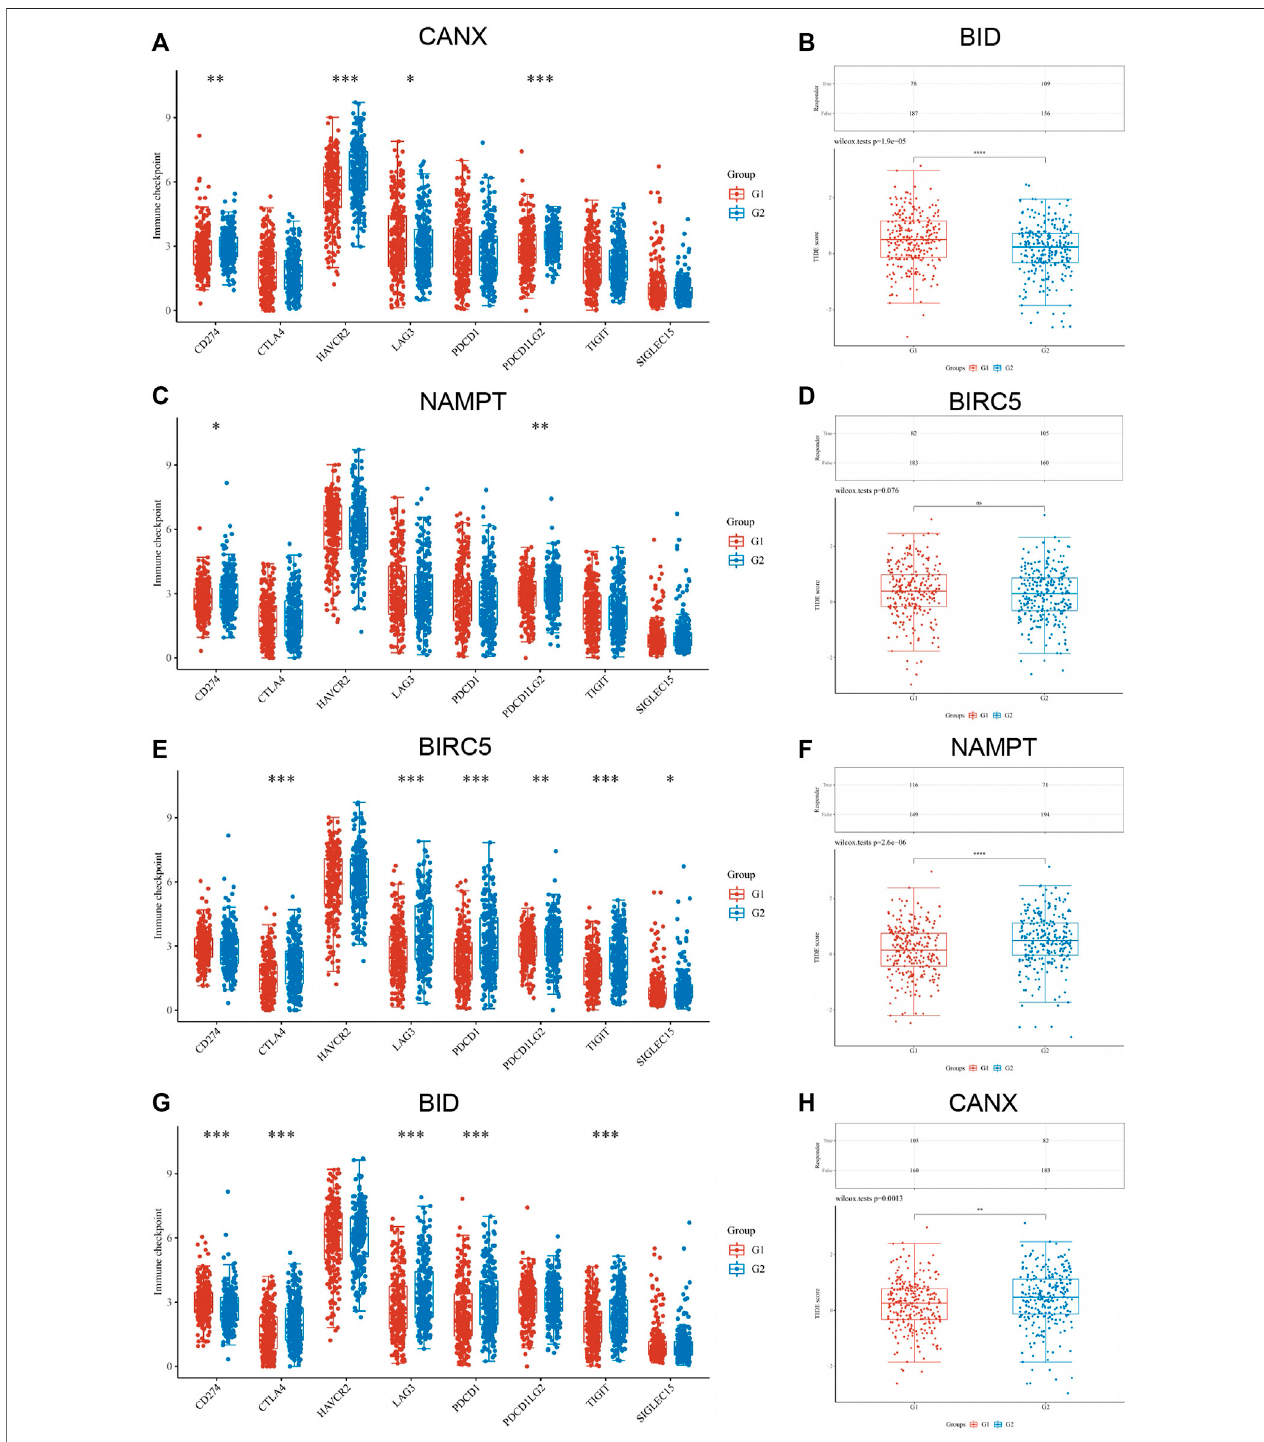
FIGURE 8 | Correlation between the expression of immune checkpoint in kidney renal clear cell carcinoma (KIRC) tissues and immune-autophagy-related differentially expressed genes (DEGs). The differenceof expression ofimmune checkpoint in KIRC tissues with high and low CANX (A) , NAMPT (C) , BIRC5 (E) , and BID (G) geneexpression.ThedifferenceofexpressionofICBresponseinKIRCtissueswithhighandlowBID (B) ,BIRC5 (D) ,NAMPT (F) ,andCANX (H) geneexpression.G1 is a low-expression group, and G2 is a high-expression group.